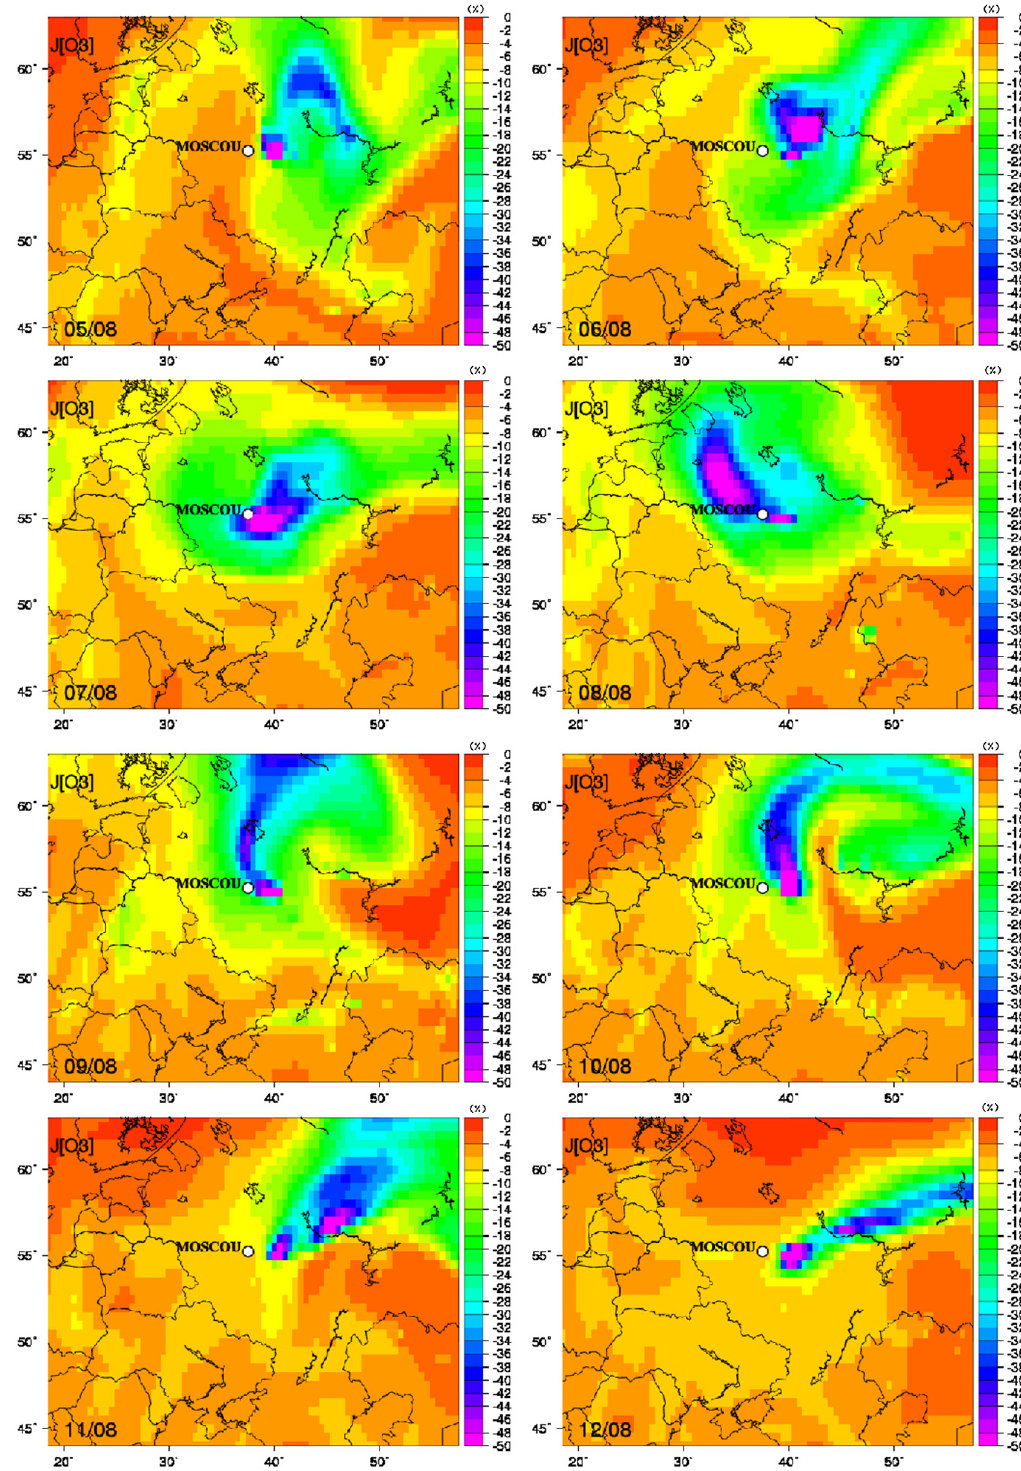
Figure 4. Geographic distribution of the modeled daytime average percentage changes in the near-surface J [O 3 ] due to the presence of